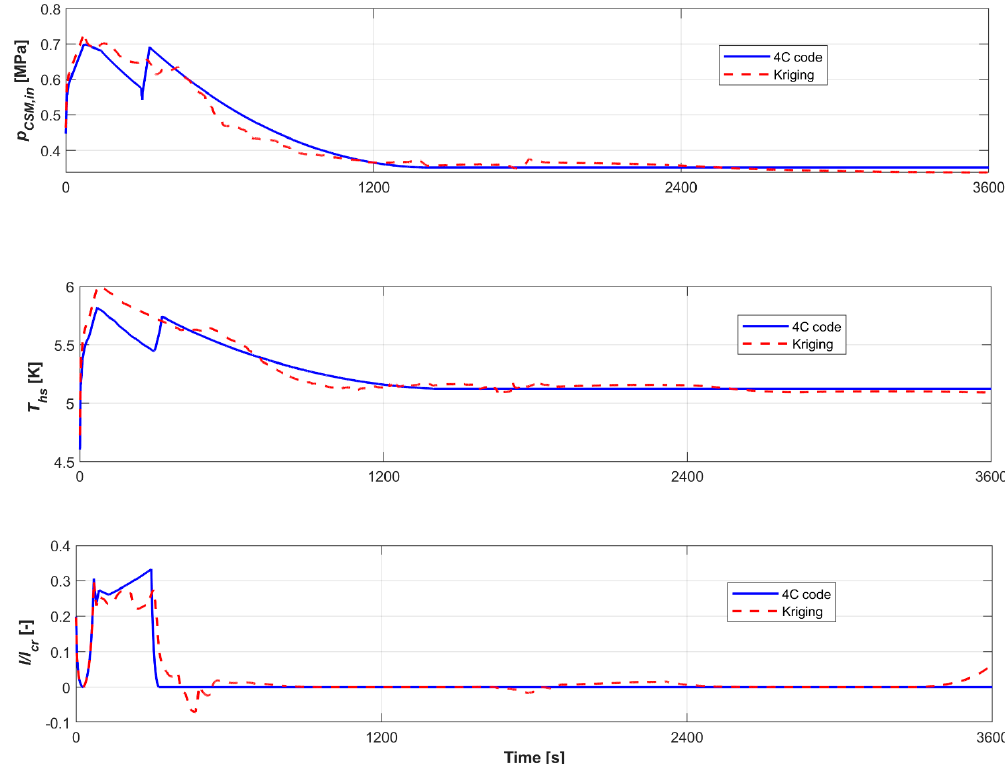
Figure 10. Comparison between the outputs obtained from the real 4C code (solid, blue) and the POD-based Kriging “surrogate” (dashed, red) for a scenario characterized by the partial opening of SV at 138 s and the complete closure of CV2 at 292 s.